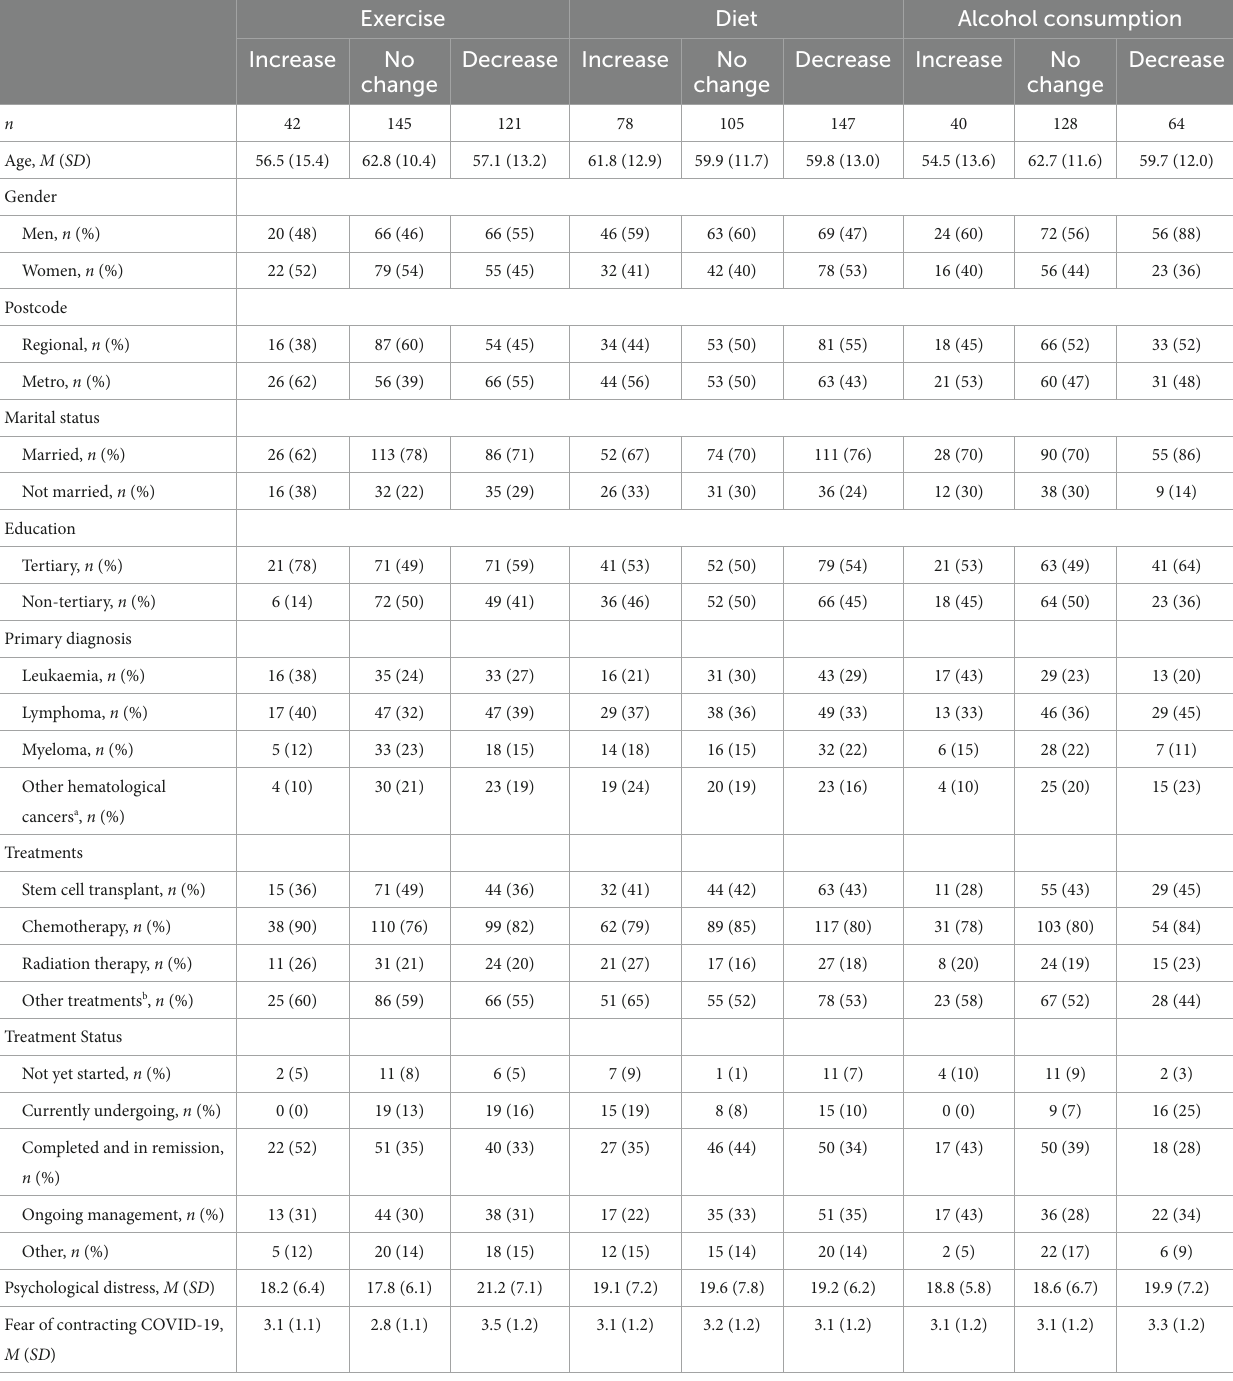
TABLE 1 Demographic and medical characteristics of respondents by changes in healthy lifestyle behaviors ( n = 394).